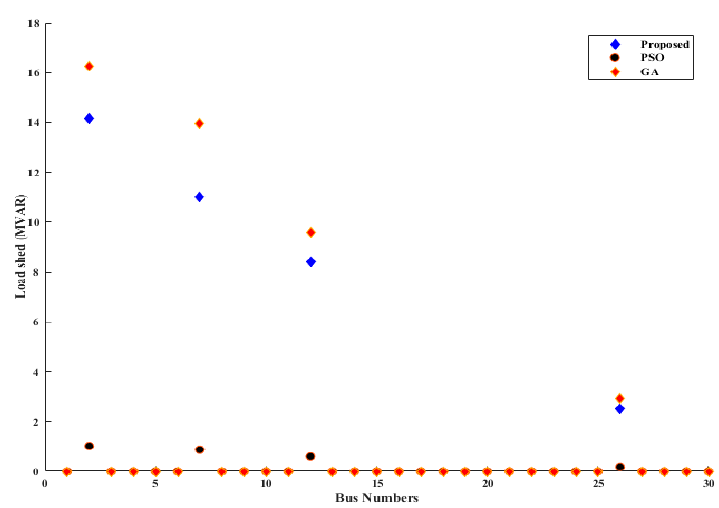
Figure 9. Load shed on each bus.